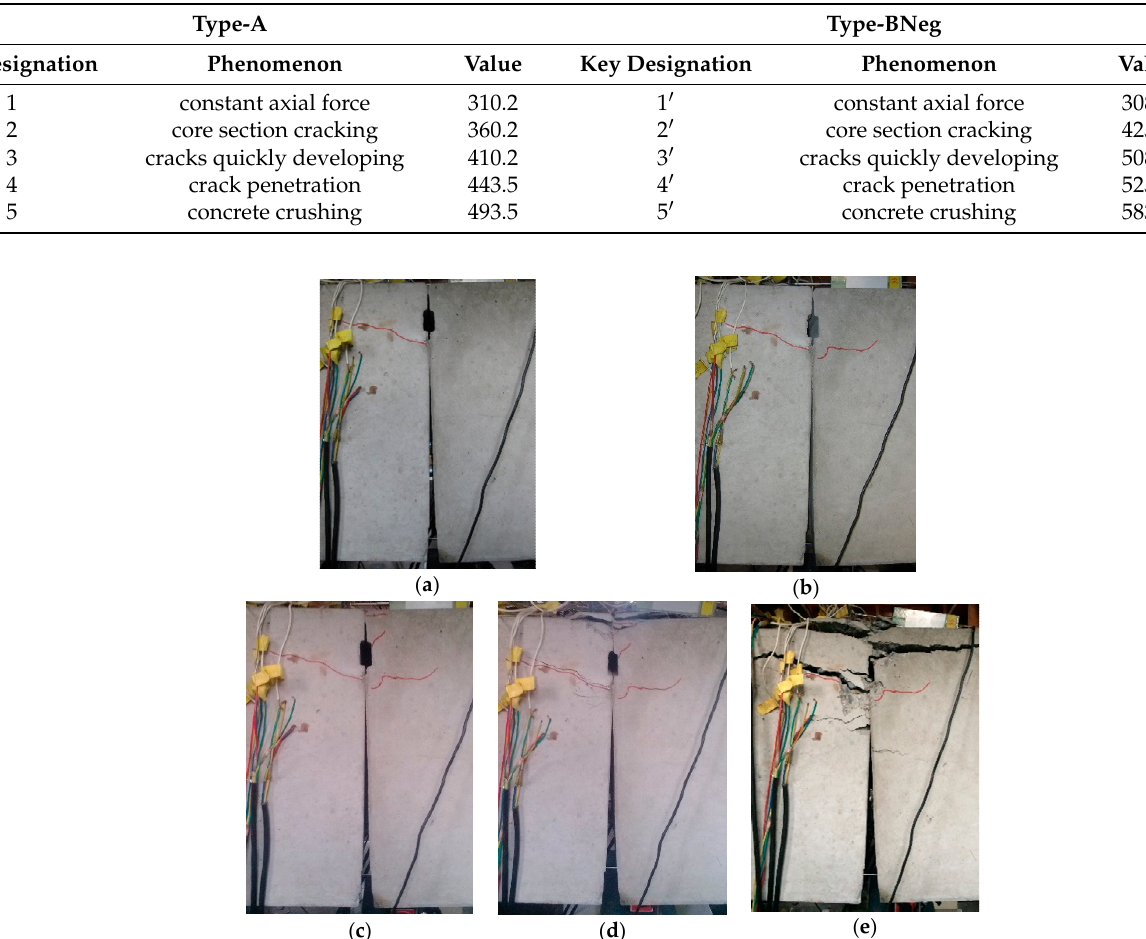
Figure 14. Type-A joint under a positive bending moment: ( a ) core section cracking; ( b ) outer edge contacting; ( c ) outer section cracking; ( d ) crack penetration; ( e ) concrete